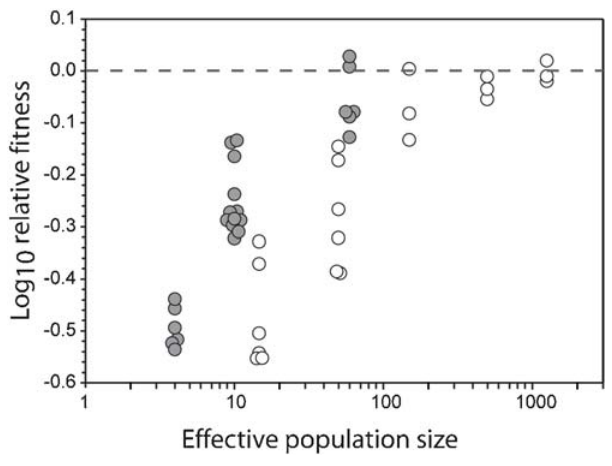
Figure 3. Equilibrium drift load as a function of population size for vesicular stomatitis virus and w X174. Each point indicates the mean fitness of a population. The VSV populations are shown in dark grey and the w X174 are shown in white. Some points have been displaced on the x-axis for clarity. The VSV populations were transferred at effective population sizes of four, ten, and 60; the w X174 populations were transferred at effective population sizes of 15, 50, 150, 500, and 1250. The dotted lines specify the maximum likelihood estimate of the f ref value (the maximum attainable fitness); the dark dotted line indicates the value for VSV and the lighter dashed line indicates the value for w X174.